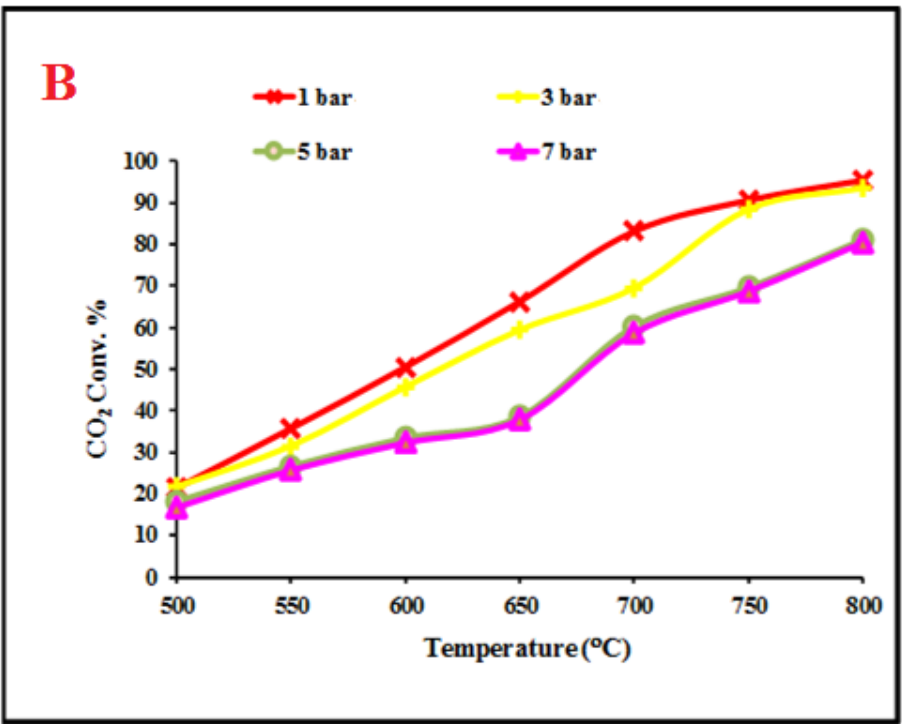
Figure 5. Catalytic activities of perovskite catalyst calcined at 725 ◦ C, using 0.05 g of catalyst and CH 4 : CO 2 :N 2 = 30 / 30 / 10 mL / min. at GHSV of 84000 mL / g / h at T = 500–800 ◦ C. ( A ) CH 4 conversion, ( B ) CO 2 conversion.